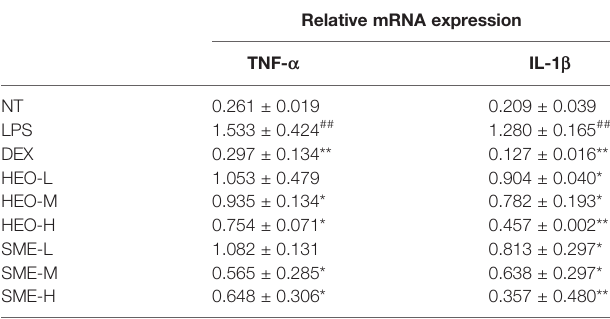
TABLE 3 | Upstream mRNA expression of TNF- a and IL-1 b . Relative mRNA expression